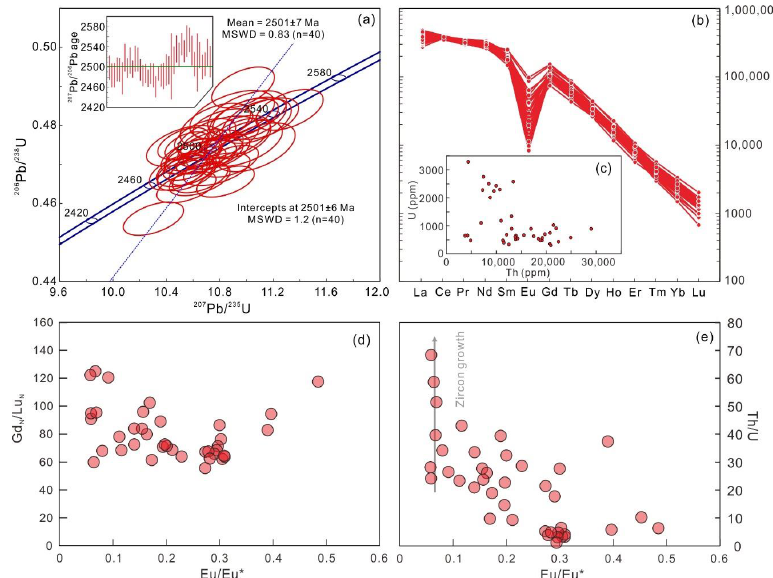
Figure 6. ( a ) U – Pb isotopic age distribution and average of analyzed monazites. ( b ) Chondrite- normalized REE patterns for the monazites (normalizing values after [55]). ( c ) Th versus U diagram for the monazites. ( d,e ) Eu/Eu* versus (Gd/Lu) N and Th/U diagrams for the monazites.